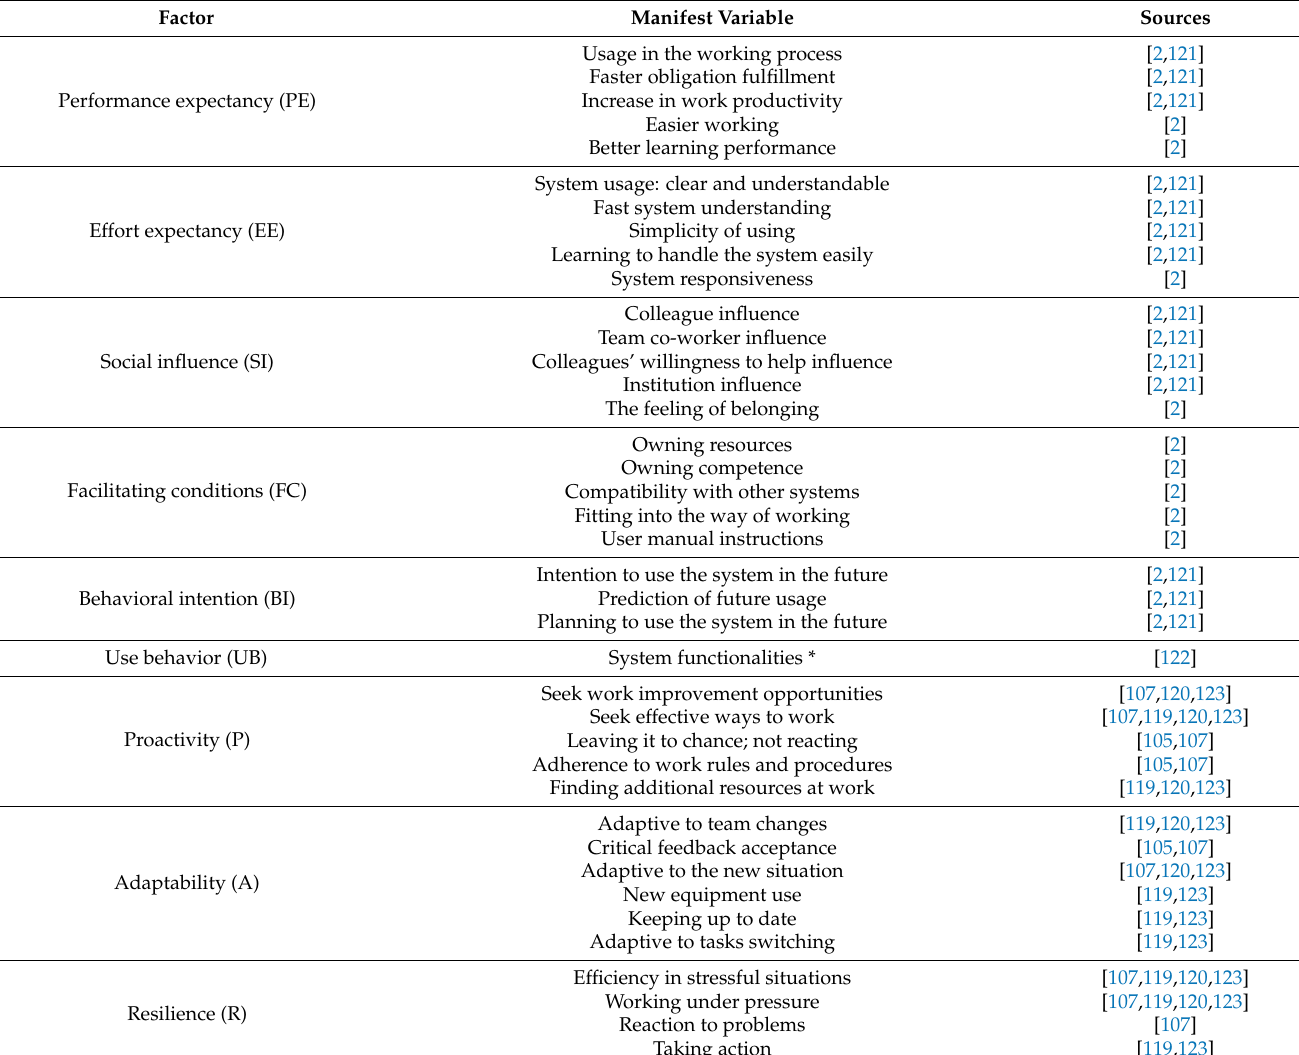
Table 2. Nine factors with associated manifest